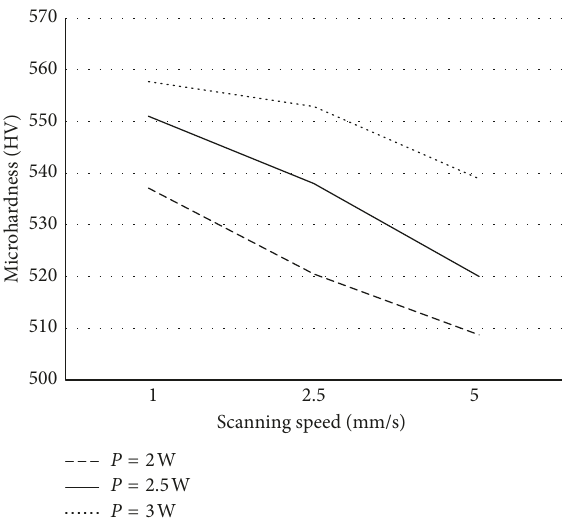
Figure 8: Microhardness of laser-processed surfaces.